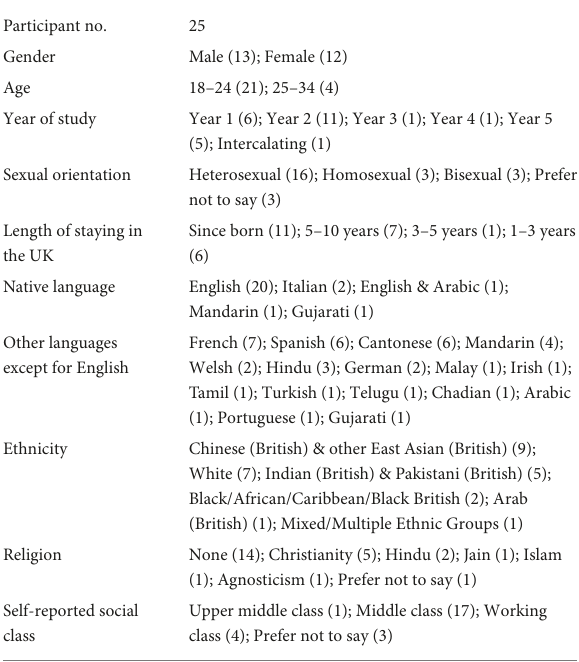
TABLE 2 Demographic information of interview participants ( n = 25).